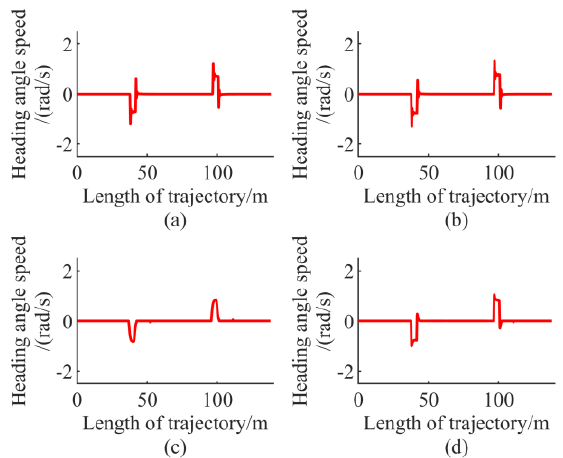
Figure 2. The velocity when velocity is 2 m/s. ( a ) LMPC. ( b ) LEMPC. ( c ) NMPC. ( d ) NEMPC.